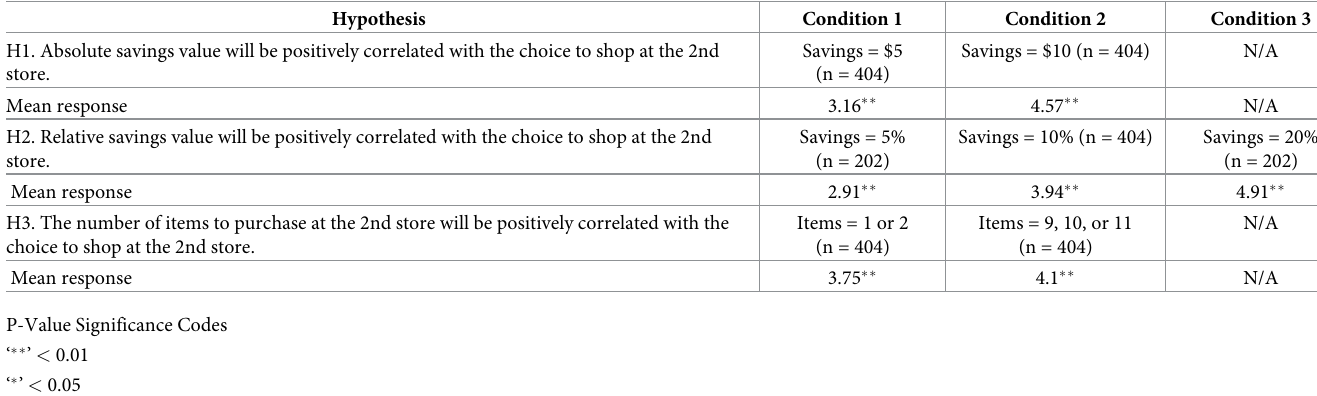
Table 4. Hypothesis results (paired t-test and ANOVA) (Study